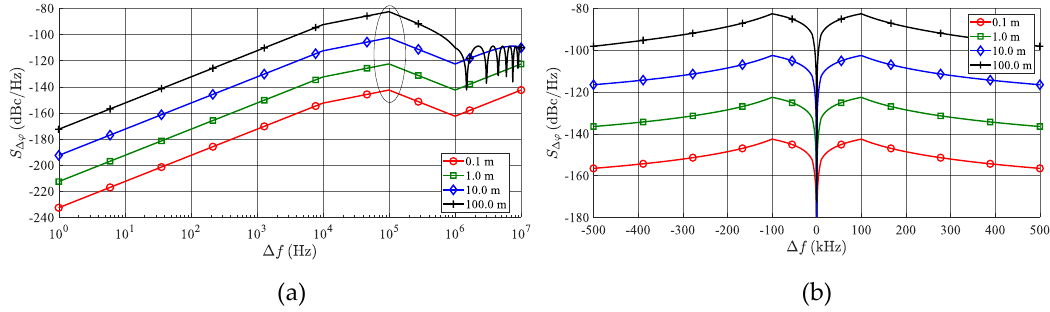
Figure 8. Phase noise spectral density ( S ∆ ϕ ( ∆ f )) of the TS up-converted output signal for an LO source with L ( f ) shown in Figure 7. ( a ) Plotted for the positive values of ∆ f in a log scale, frequency range 0–10 MHz. The marked frequency range is crucial when simulating more artificial targets at a single azimuth. ( b ) For both the positive and negative frequencies of ∆ f in a linear frequency scale, at a frequency range of ±500 kHz.